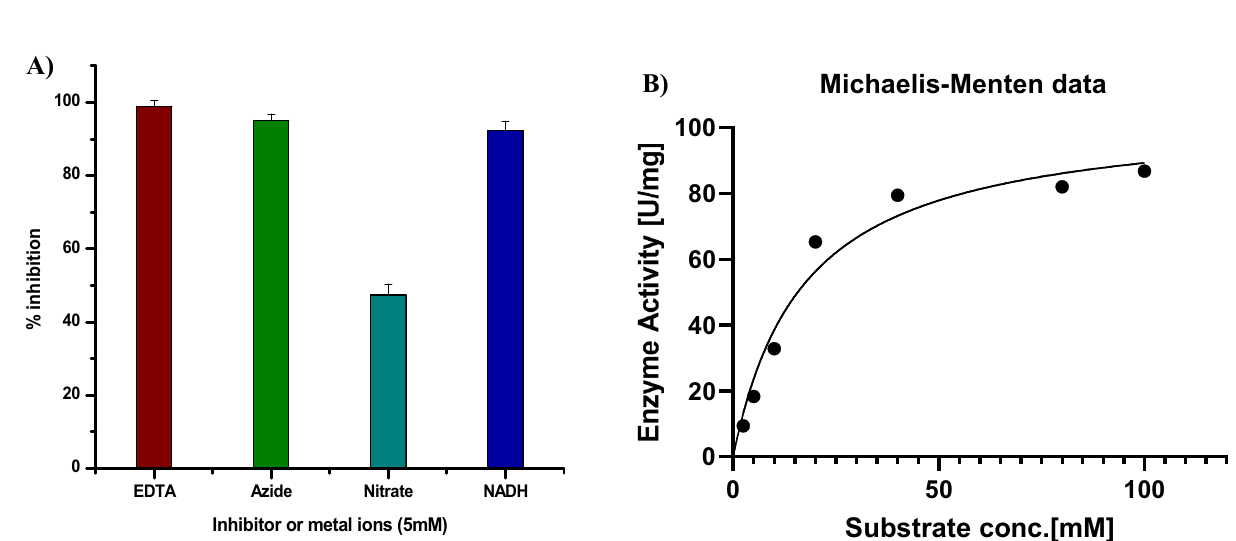
Figure 5. Characterization of NO production by the NirK protein: ( A ) Percent inhibition of the NO production by inhibitors (EDTA, azide, nitrate and NADH) was calculated using the formula {(Control-Test)/ (Control- Blank)}*100, where control is without any inhibitor or metal ions and test is the treated one. ( B ) Kinetics of NO formation by purified NirK protein in presence of nitrite. NO synthesis was fluorometrically monitored in presence of different concentrations of nitrite (2.5 to 100 mM) in 50 mM HEPES buffer at pH 7 as well as fixed small quantity of the purified protein. K m value of Mtb NirK for nitrite was determined by using Graphpad software. The plot was drawn by taking nitrite reductase activity with different nitrite concentrations (2.5 to 100 mM) at pH 7. The data is represented as the mean values obtained from triplicate experiments ±